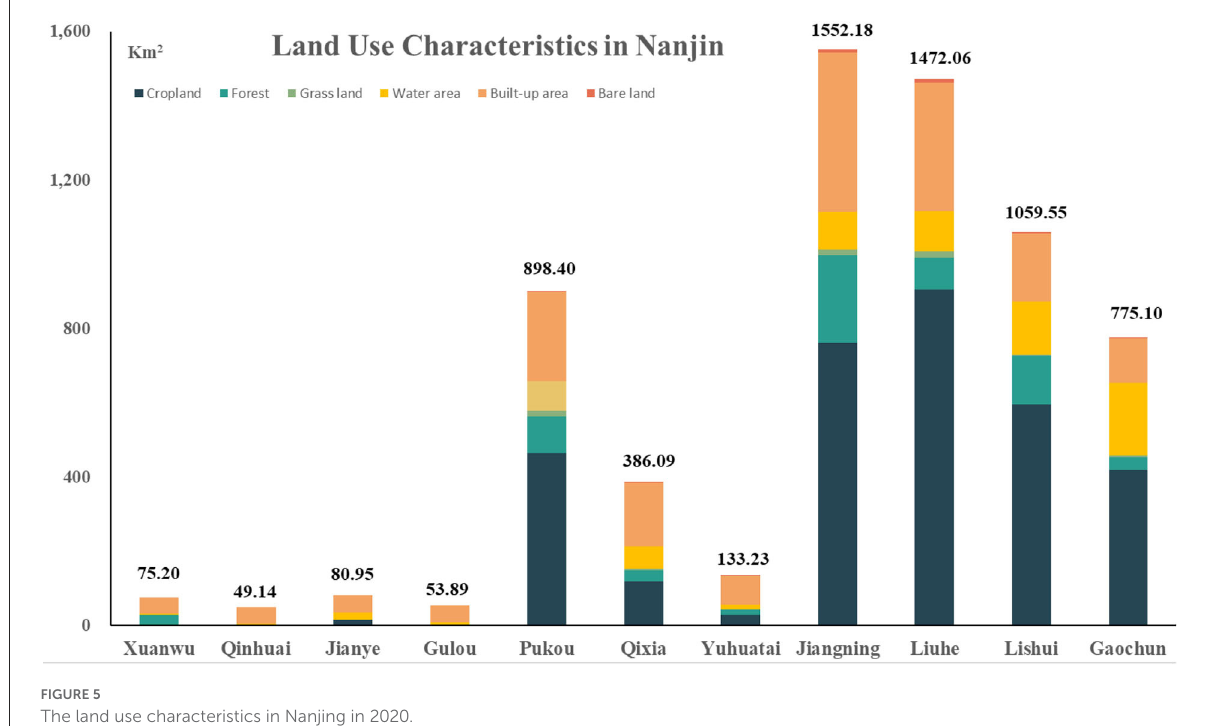
FIGURE5 The land use characteristics in Nanjing in 2020.